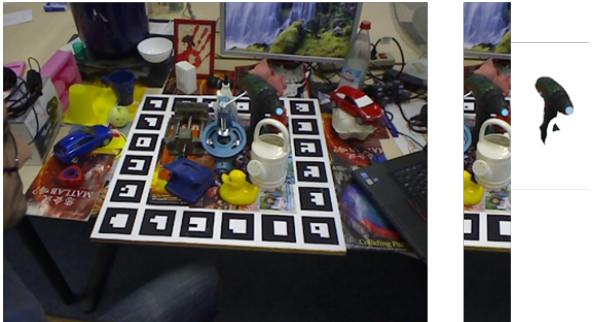
Figure 6. Local perception for